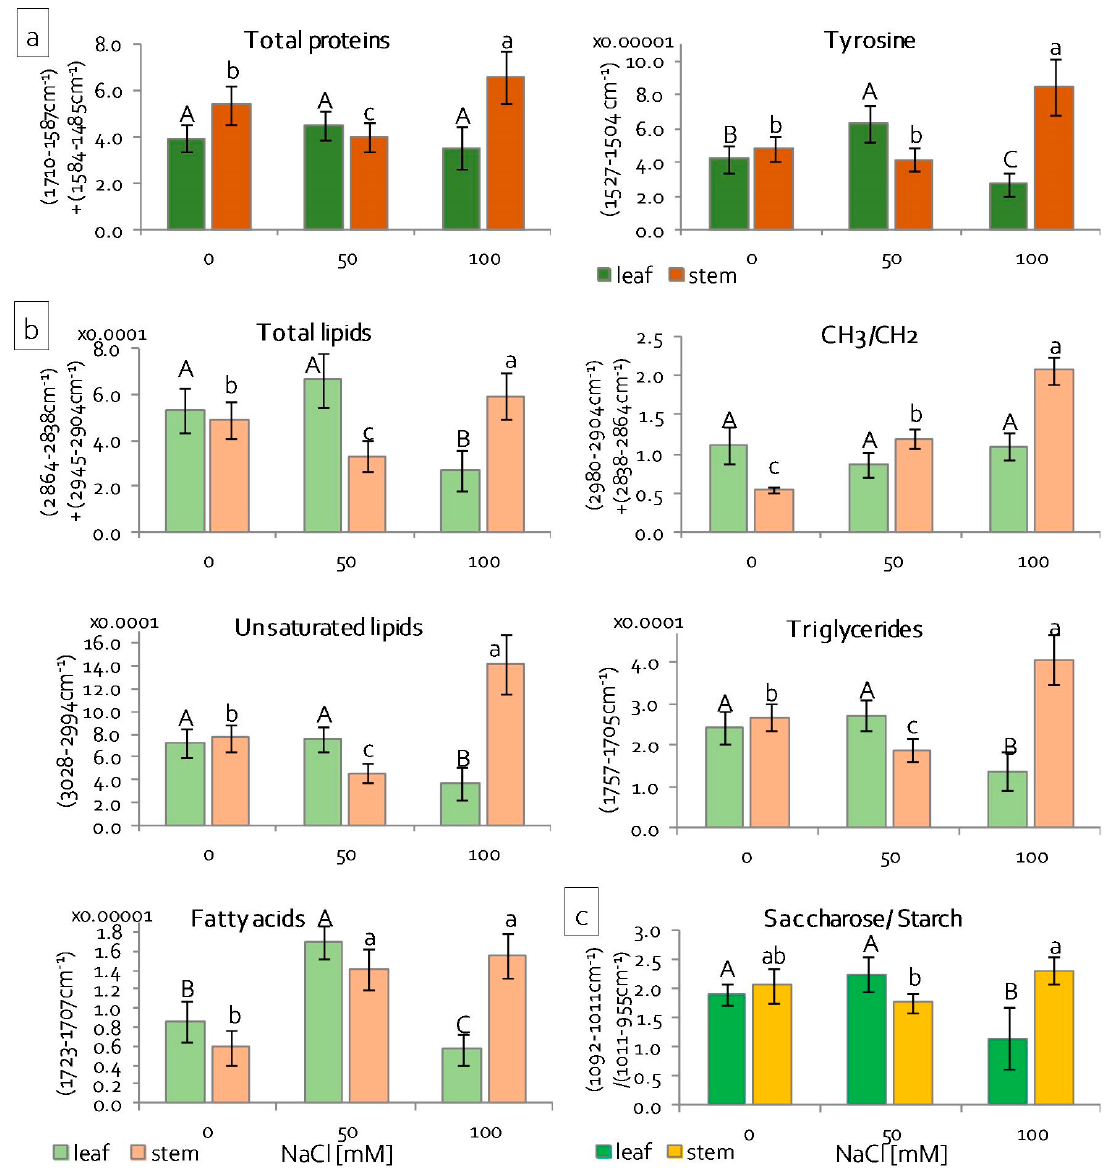
Figure 10. Semi-quantification of chloroplast biocomponents in leaves and stems identified in attenuated total reflectance—Fourier-transform infrared (ATR-FTIR) spectra: ( a ) proteins and Tyr residues, ( b ) lipid fractions, and ( c ) saccharides. Intergraded spectral regions are listed in Experimental Section; different letters—statistically significant differences within each organ (leaf-uppercase, stem-lowercase) at p ≤ 0.05; ( n = 3).